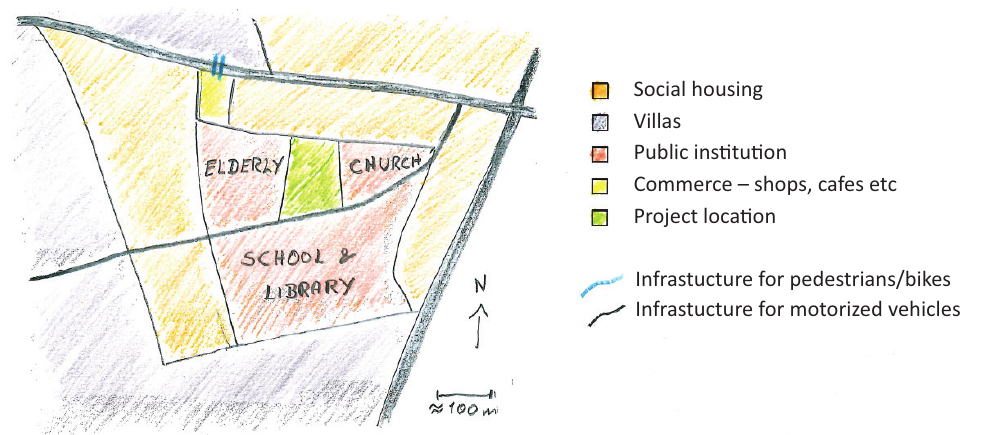
Figure 3. The Garden: The project’s location in the neighbourhood of